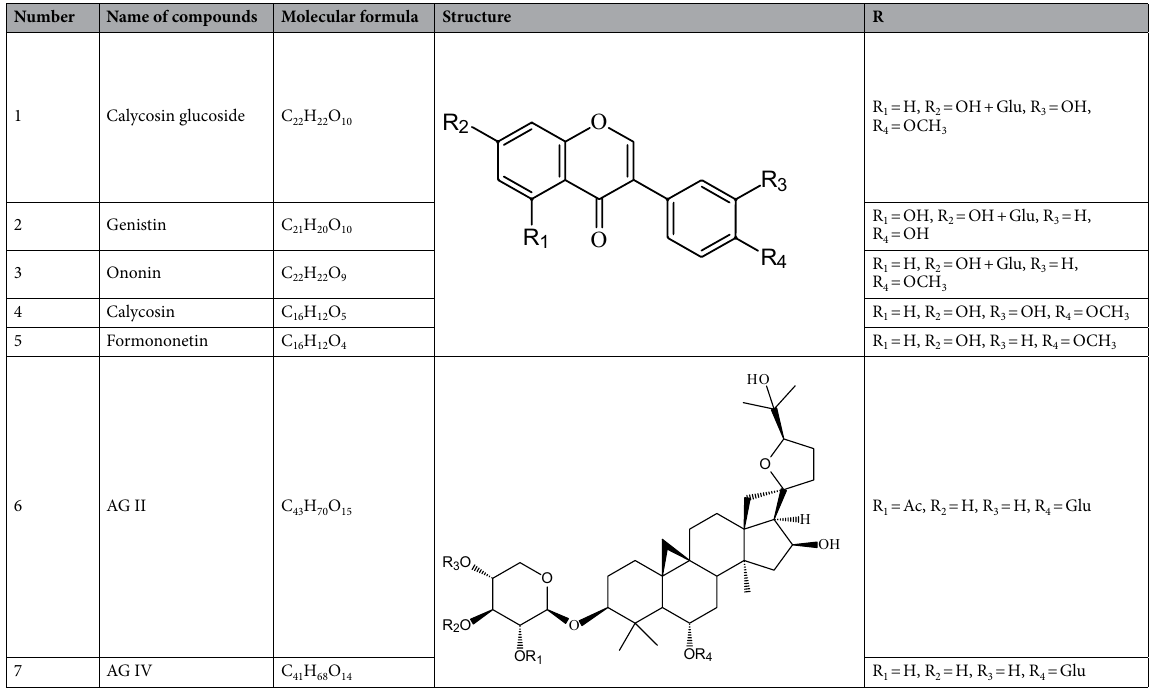
Table 5. Chemical structures of relevant flavonoids and saponins in Radix Astragali . Glu, glucose; Ac, acetyl